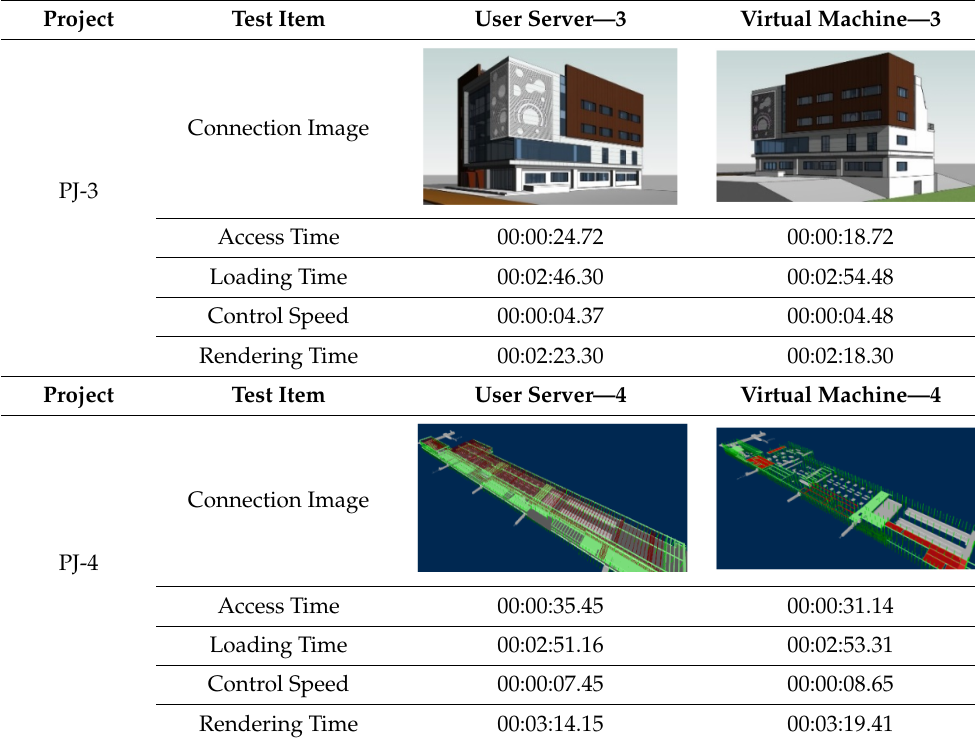
Table 17. Processing time standard personal computer and virtual machine (for Revit)—Project 3, 4.